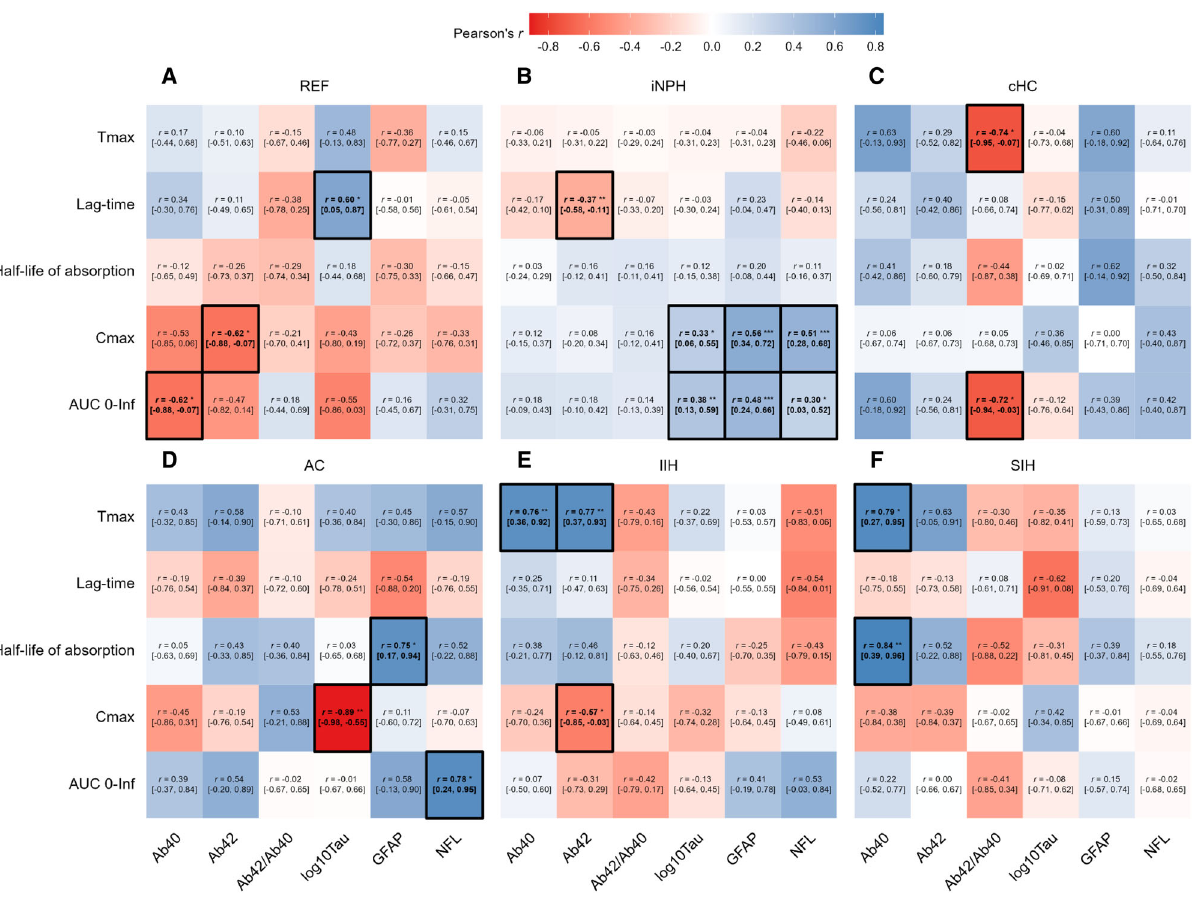
Fig. 4 | Associations between CSF-to-blood clearance parameters and bio- marker concentrations for the different disease categories. The associations between CSF-to-blood clearance pharmacokinetic variables and plasma biomarker concentrationsareshownasPearson ’ scorrelations( r )[95%con fi denceinterval]for the CSF disease categories A reference (REF), B idiopathic normal pressure hydrocephalus (iNPH), C communicating hydrocephalus (cHC), D arachnoid cyst